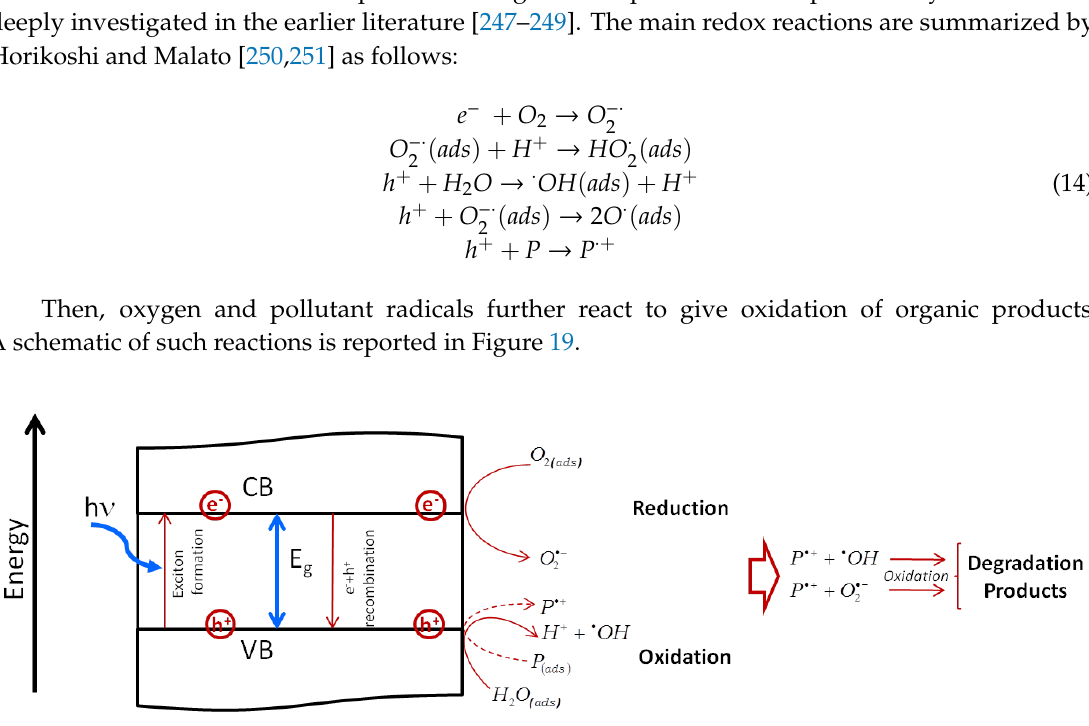
Figure 19. Scheme of redox reaction. CB: conduction band, VB: valence band.